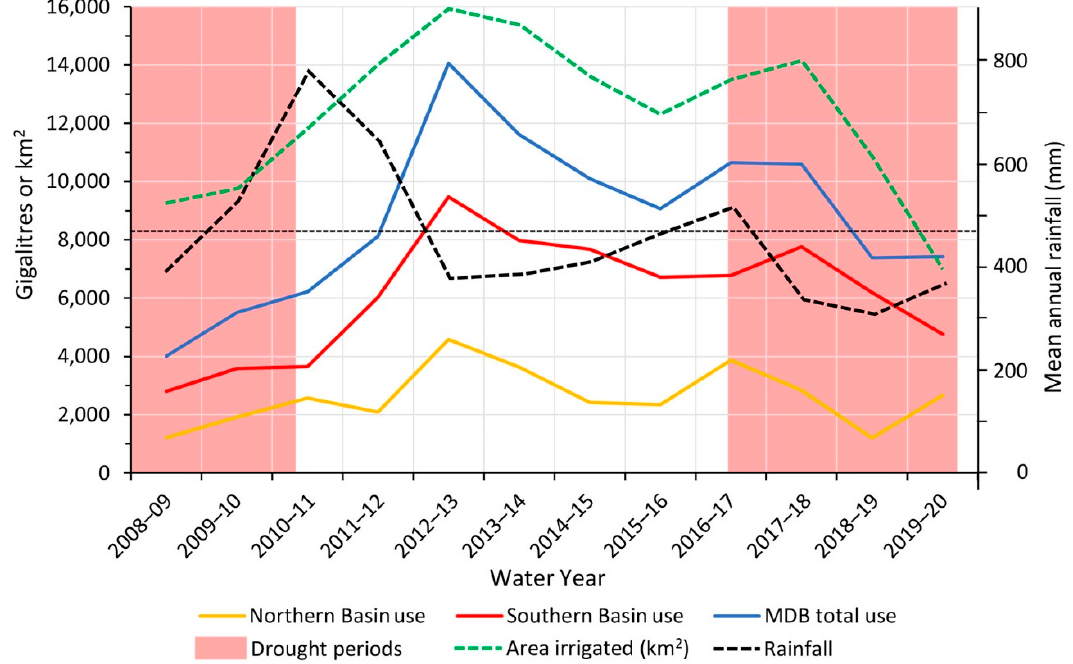
Figure 4. Irrigation water use in the Murray–Darling Basin from 2007–08 (when the Water Act received assent) to 2020–2021 (solid lines; for northern and southern Basin and total), compared with the annual area irrigated and rainfall (black dashed line; long-term mean of 464 mm shown as black horizontal line). Data on irrigation water use from MDBA water audit monitoring reports on Cap